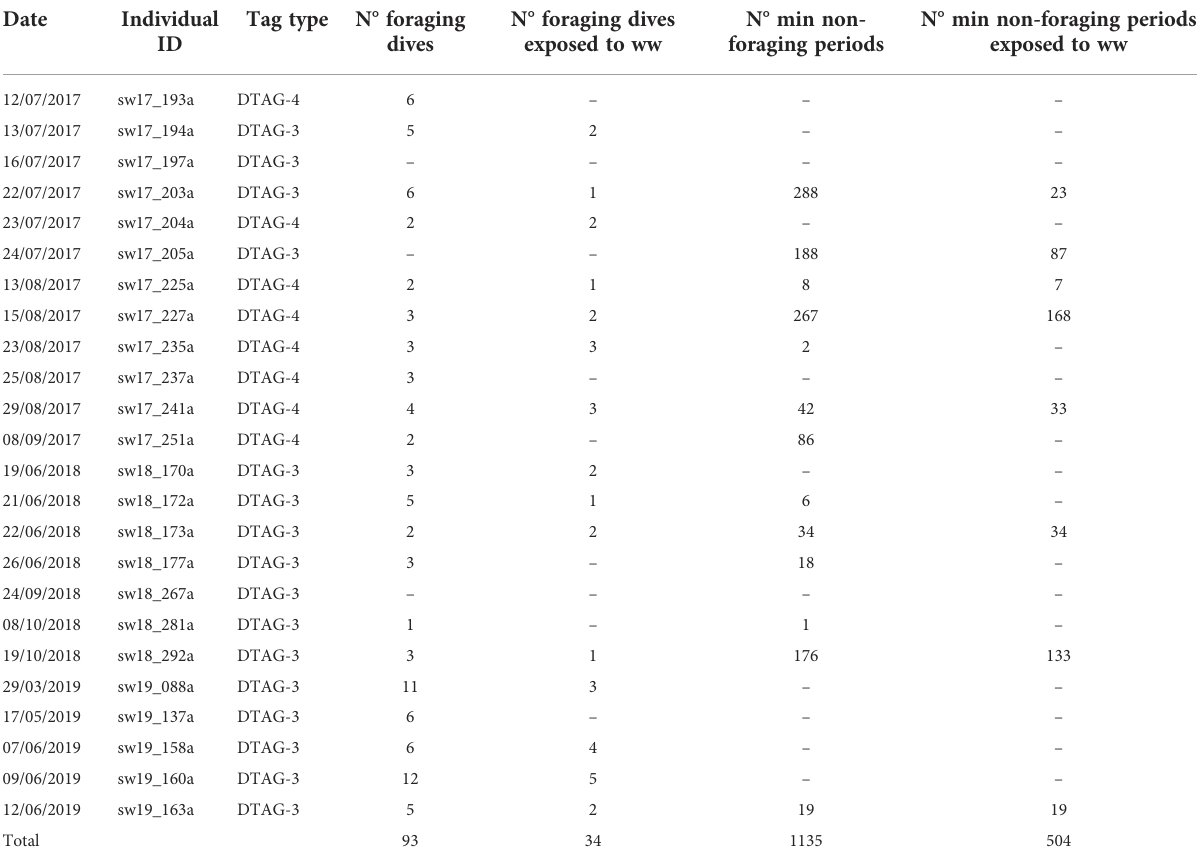
TABLE 3 Summary of the data